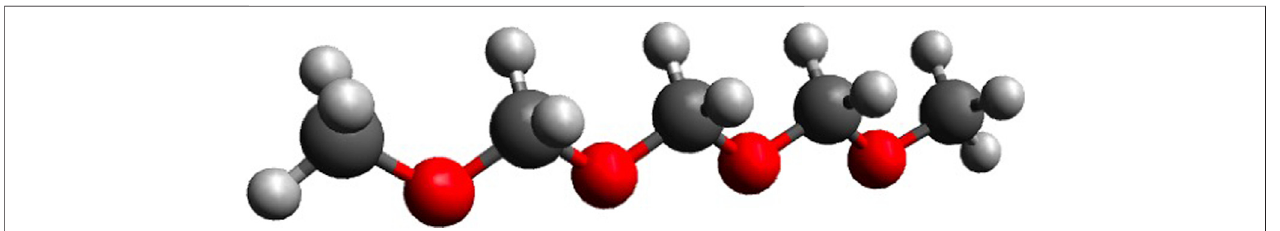
FIGURE 4 | The structure of OME 3 (built in Avogadro, 2021).